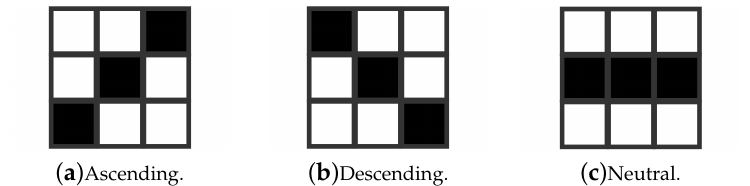
Figure 4. Templates for searching tendencies in time-series W . Ascending template ( a ) corresponds to terms of movements: flexion, abduction, internal rotation and pronation. Descending template ( b ) corresponds to movements of extension, adduction, external rotation and supination. And neutral template ( c ) matches the cases without a clear